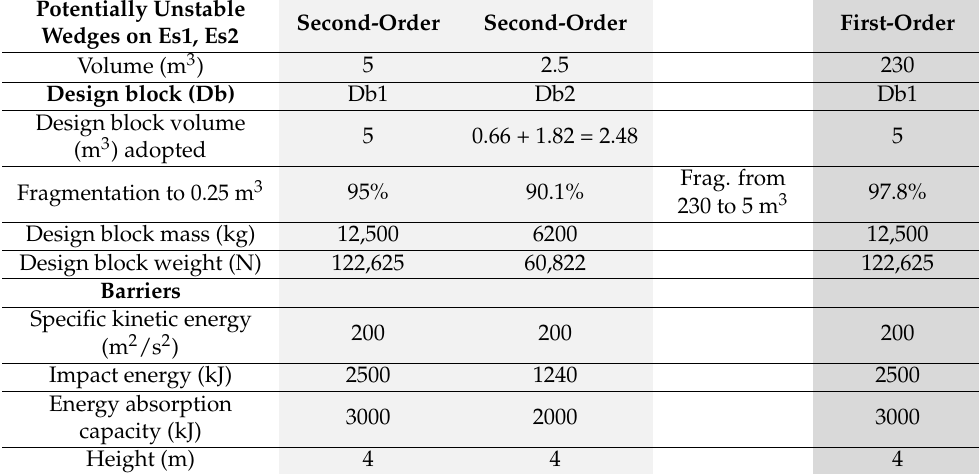
Table 4. Main characteristics of unstable wedges or rock escarpments, design blocks (Db), and protection